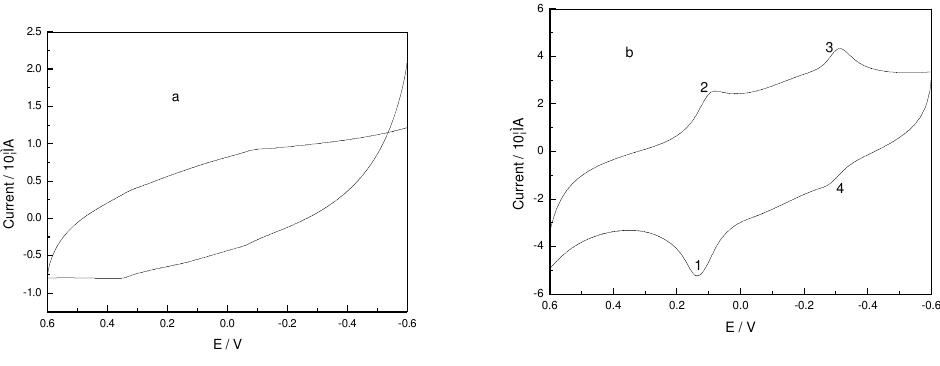
Figure 2. Cyclic voltammograms of 1.0×10 -4 mol/L DA in pH 7.4 PBS. (a) At the bare electrode, (b) At the modified electrode. Sensitivity: 1.0×10 -4 A/V. Scan rate: 100 mV/s. At hippuric acid or 2-picolinic acid modified electrode, DA exhibited two cathodic and one anodic peak. However at poly (acridine red) modified electrode. DA exhibited two couples of redox peaks.